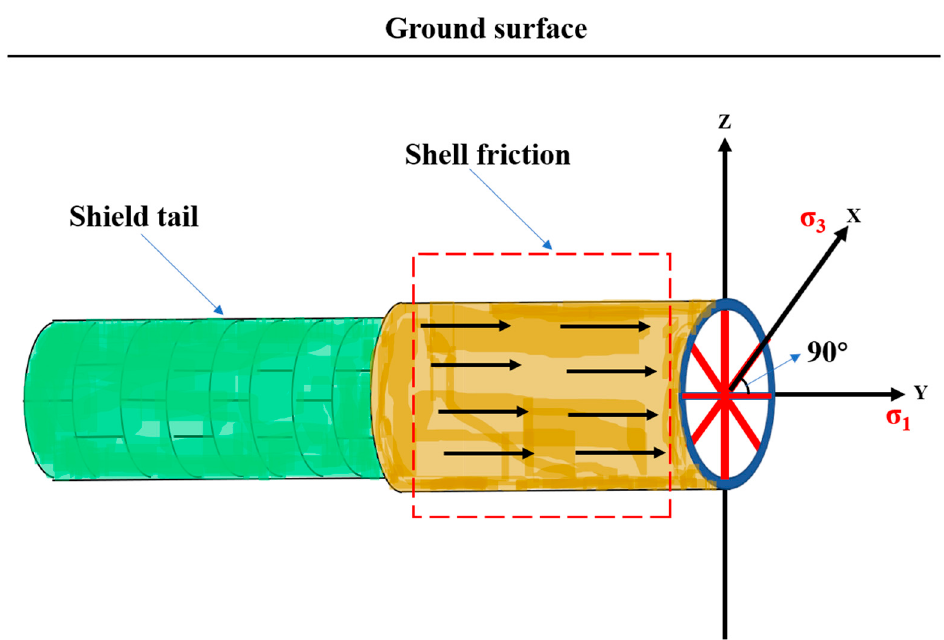
Figure 3. The directions of principle stresses around the tunnel with advancing TBM face. Table 1. Basic mechanical indexes of soil in each